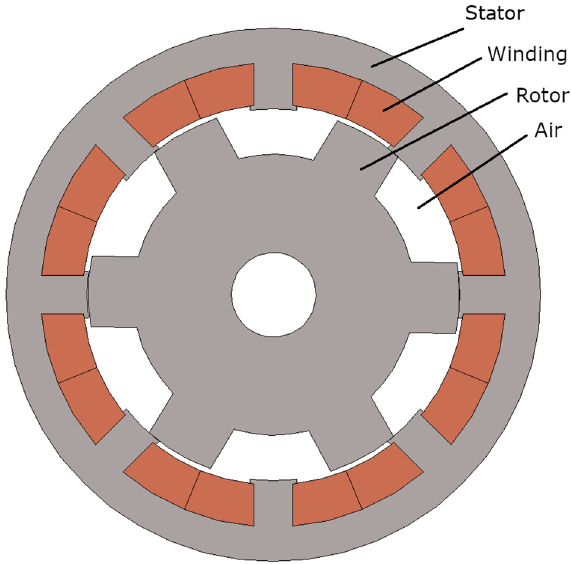
Figure 1. SRM Cross section with visible stator and rotor salient poles.